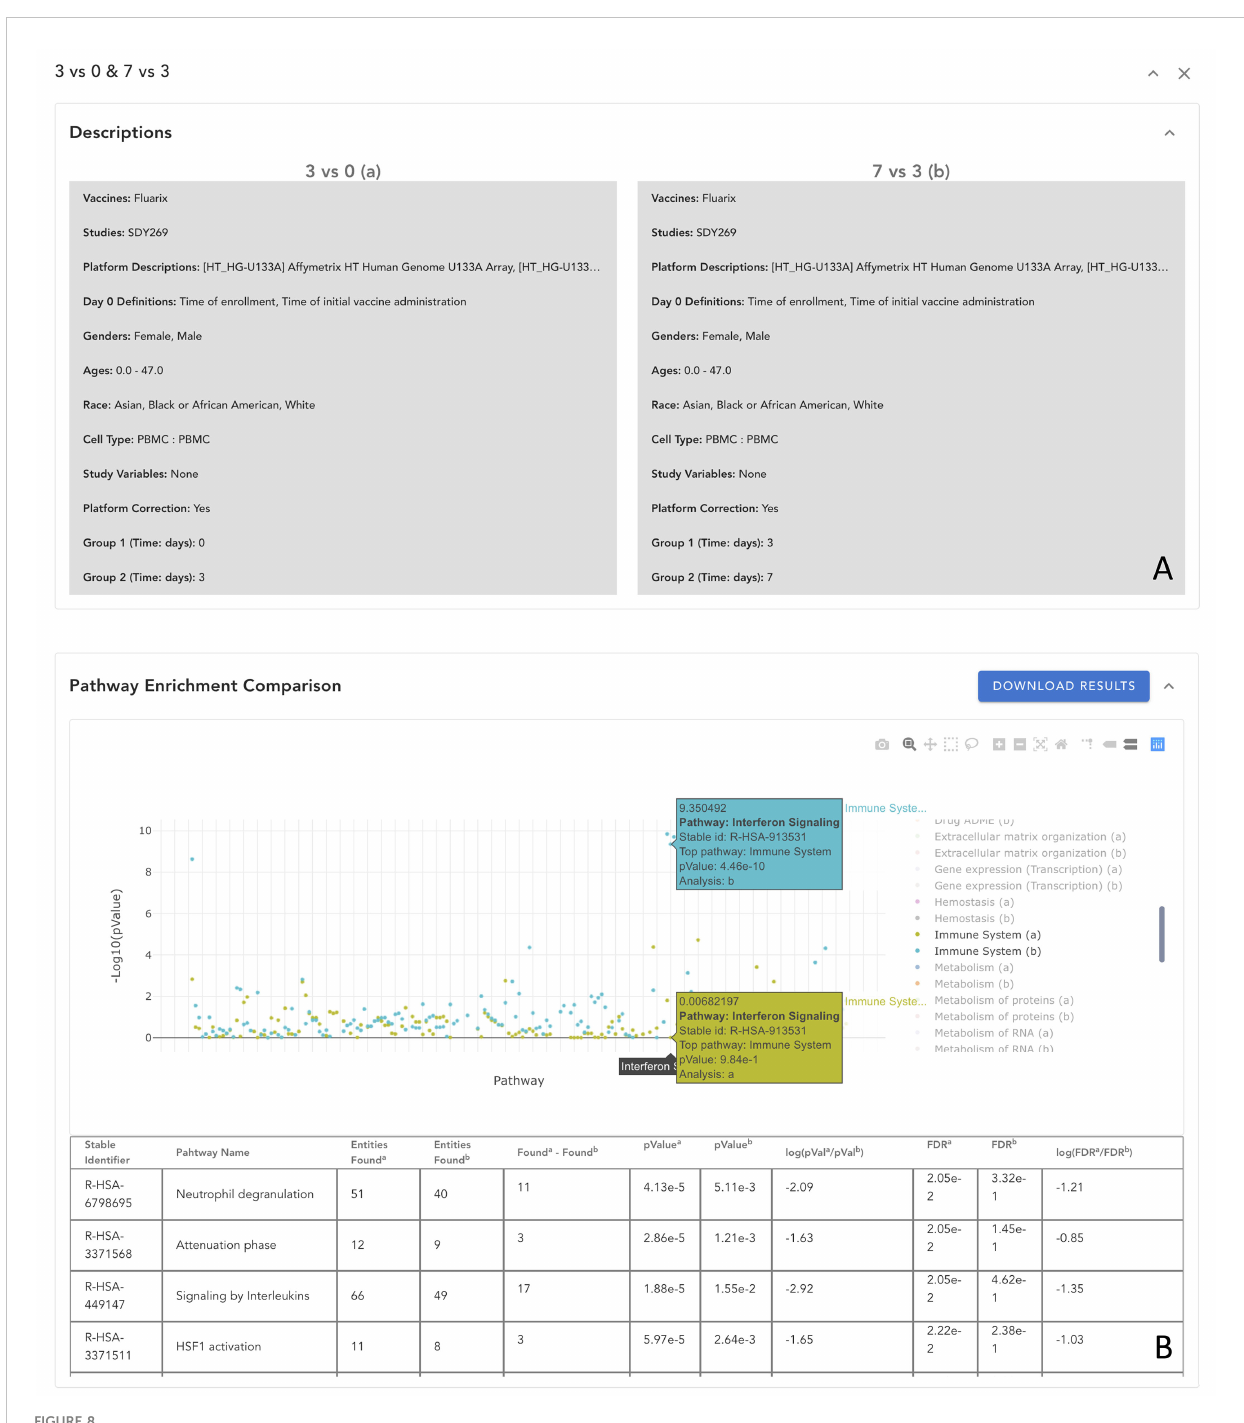
FIGURE 8 Comparison of analysis results in VIGET. A comparison analysis was set up in VIGET for two analyses in (A) between vaccine response on day 3 and day 7 post vaccination by Fluarix (an in fl uenza vaccine) collected in study SDY269. The user can compare results in a collective view such as the pathway plot view shown in (B) where only pathways annotated in “ Immune System ” are shown for simplicity. As we can see in this pathway comparison, the fi rst three days have stronger responses in the “ Signaling by Interleukin ” pathways as shown in the bottom table. However, after three days, the “ Interferon Signaling ” pathways become stronger as marked in the plot. The user can also compare results directly in the volcano plot and the network view (not shown